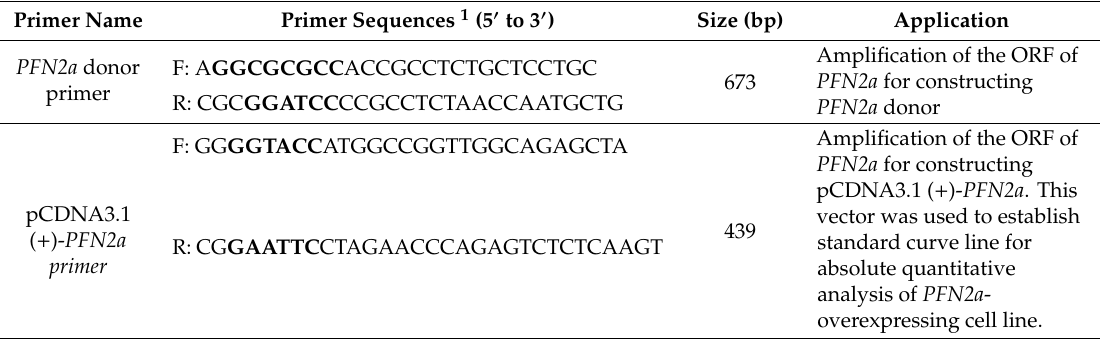
Table 1. Primers used for vector construction. ORF: open reading